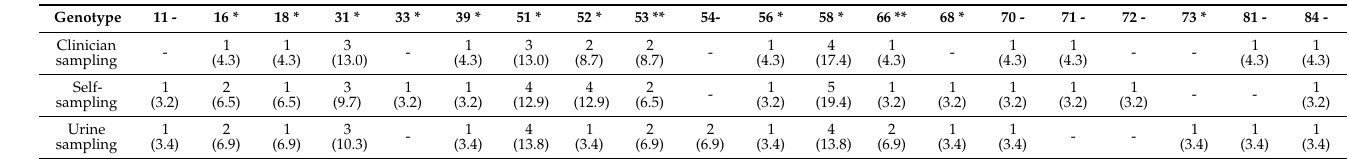
Table 2. Distribution of any type of HPV according to sampling